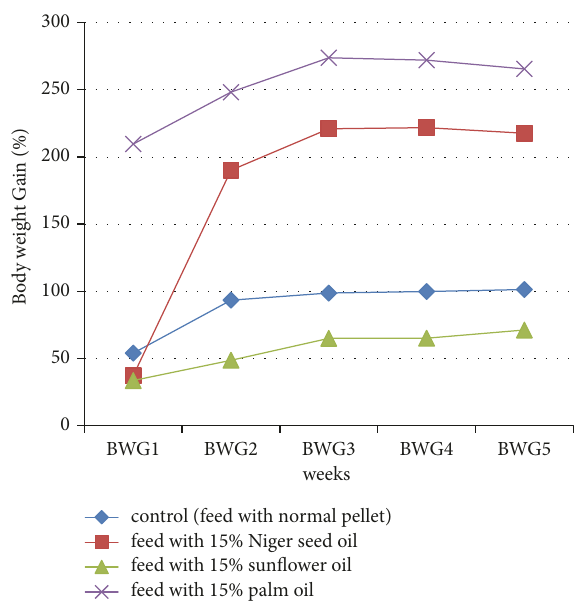
Figure 2: Characteristics of the body weight gain percentage (BWG %) of experimental animals (Wistar albino rats) (BWG1: body weight gain percentage of rats in the first one week; BWG2: body weight gain percentage of rats in the 2nd two weeks; BWG3: body weight gain percentage of rats in the 3rd two weeks; BWG4: body weight gain percentage of rats in the 4th two weeks; BWG5: body weight gain percentage of rats in the final 8th